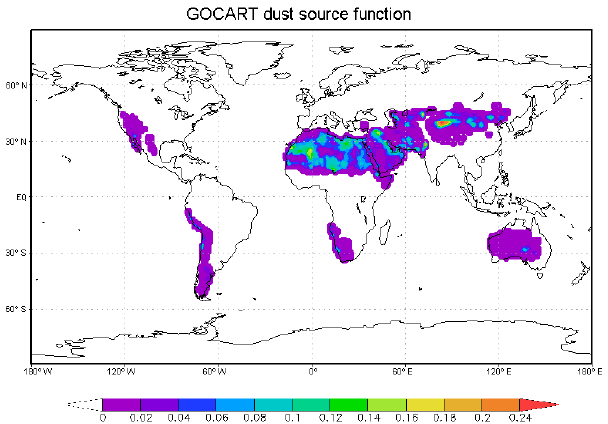
Figure 2. The dust source function or probability of dust uplifting, mapped to GFS T126 resolution, used in NGAC V1.0.